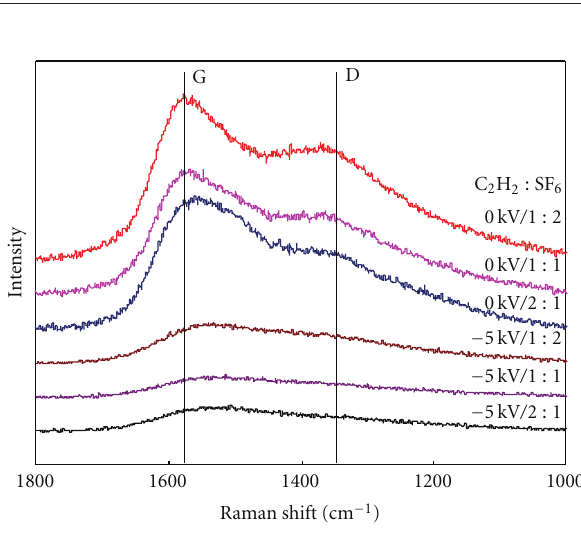
Figure 2: Raman spectra of CH-DLC films, DLC-SP film, and S- DLC